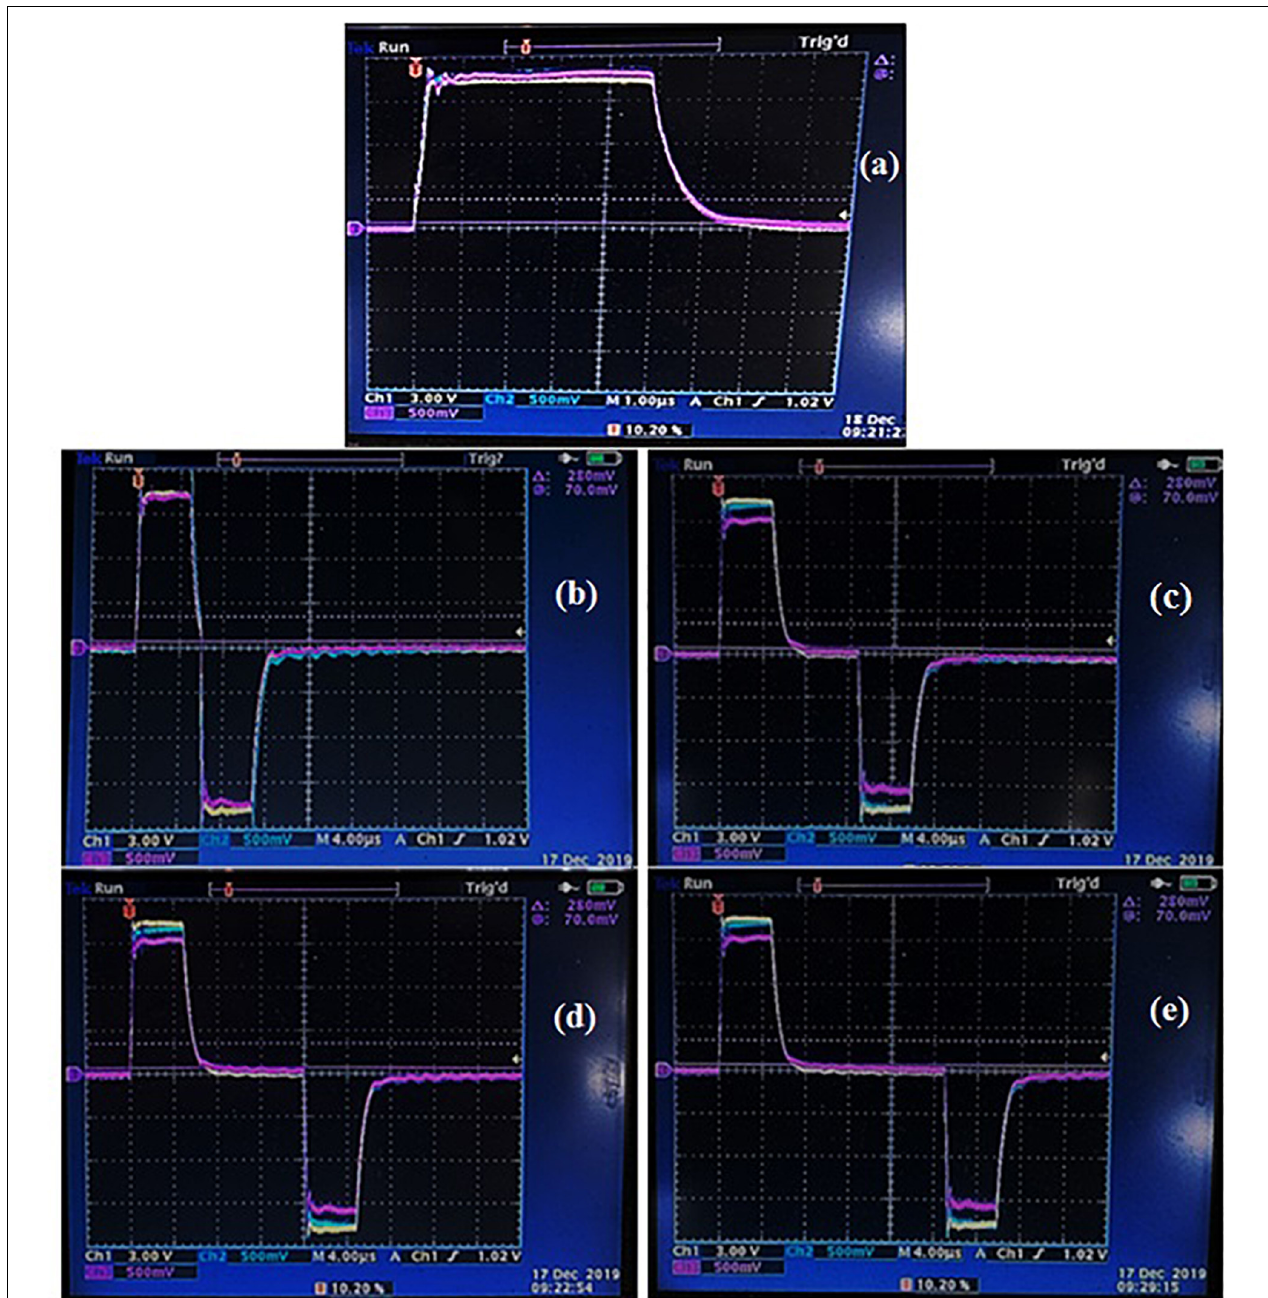
FIGURE 1 | Typical voltage and current waveforms captured at the treatment chamber for either monopolar (a) or bipolar pulses at different delay time of 1 µ s (b) , 5 µ s (c) , 10 µ s (d) , and 20 µ s (e) . Reference color: yellow: voltage waveform; light blue: current waveform at the first module of the treatment chamber; purple: current waveform at the second module of the treatment